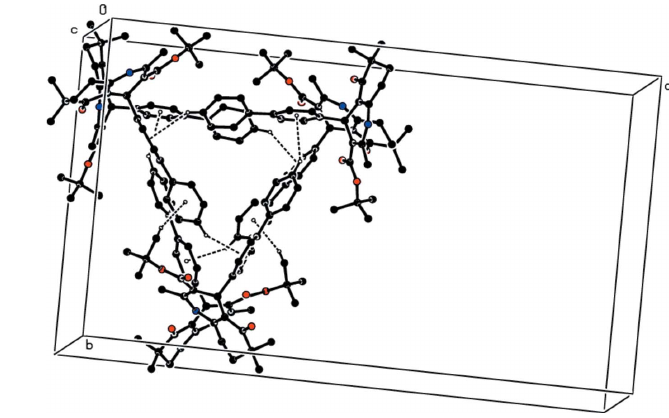
Figure 3 A view of the intermolecular N—H (cid:2)(cid:2)(cid:2) O and C—H (cid:2)(cid:2)(cid:2) O interactions in the crystal structure of the title compound projected along [100]. Only the major component of the disordered molecule C is shown.